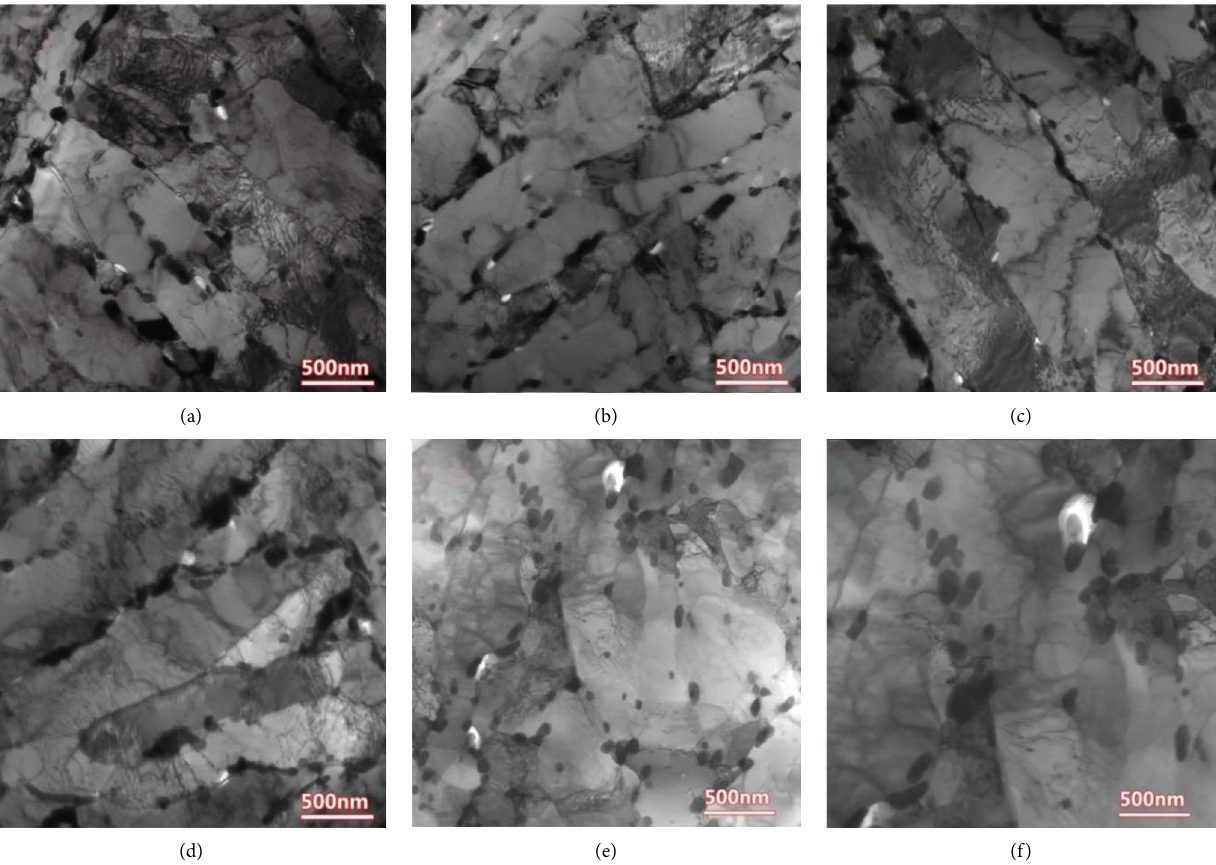
Figure 4: Typical TEM micrographs of G115 steel after aging at 650 ° C (a–c) and 700 ° C (d–f) for different times: (a, d) 1000h; (b, e) 3000h; (c, f)